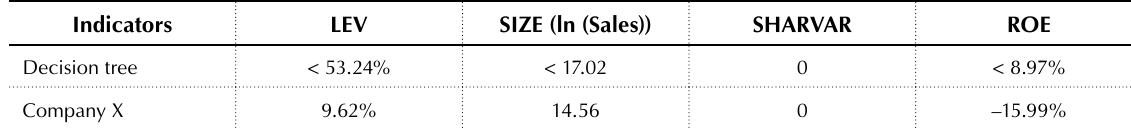
Table 4. Parameters of company X compared to the decision tree conditions for Cluster 1 “Earnings decreasing